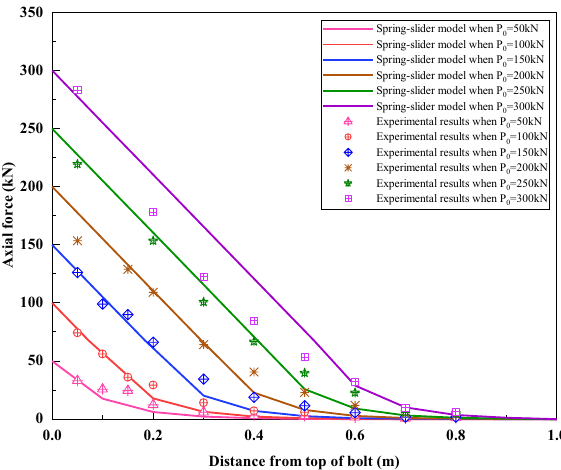
Figure 22. Comparison between the spring-slider model and the test